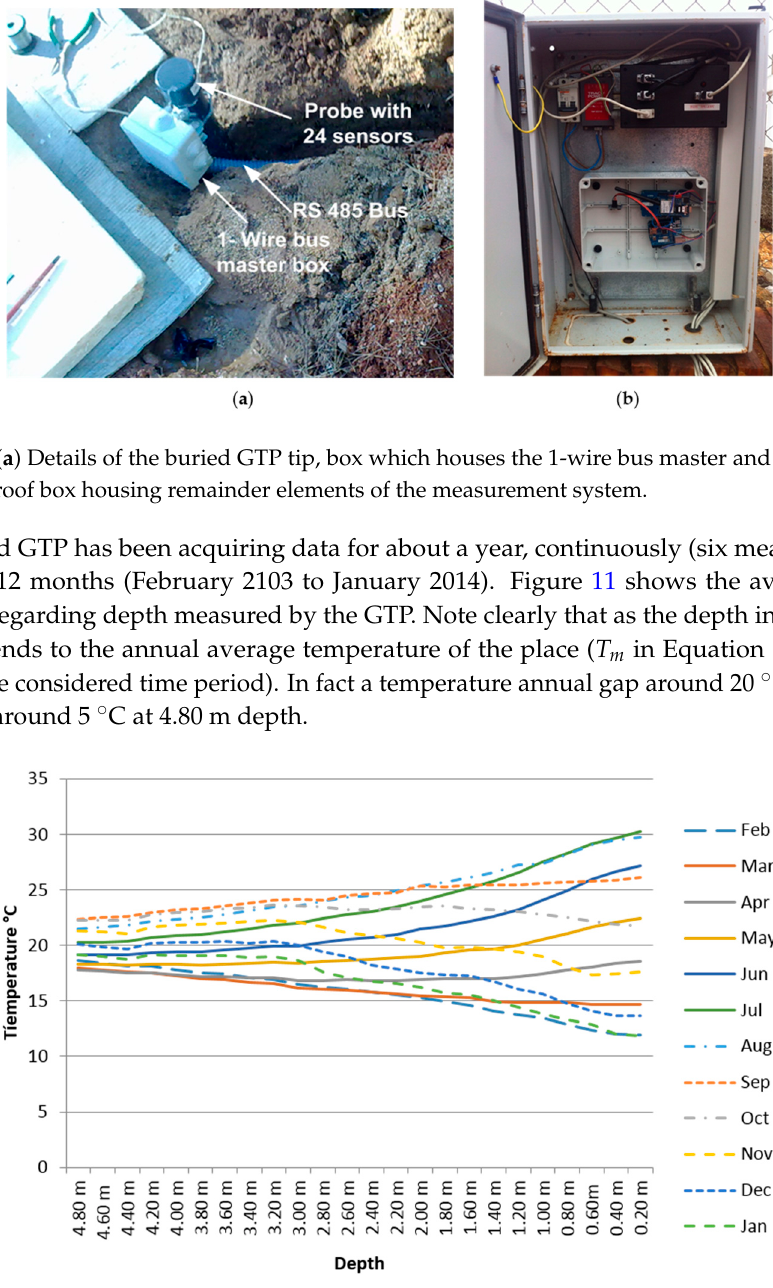
Figure 11. Behavior of the average monthly temperature regarding soil depth.